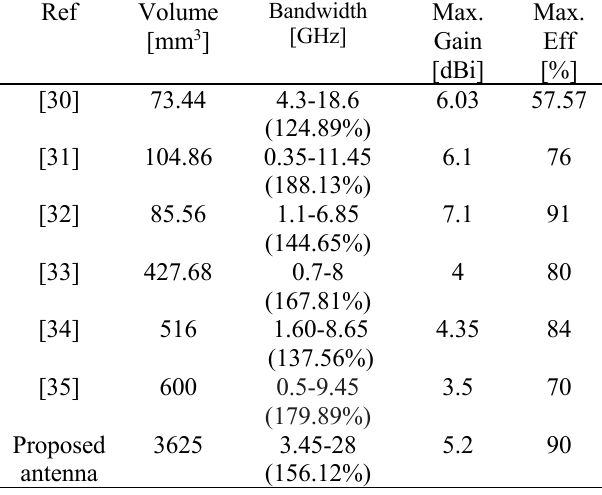
Figure 13: Simulated total efficiency of proposed DRA Table 1: Comparison between the proposed antenna and other